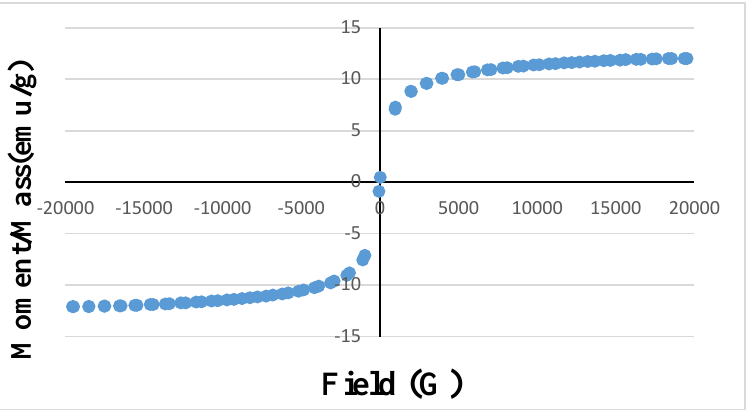
Figure 4. Magnetization curves of magnetic ZnO nanotubes.